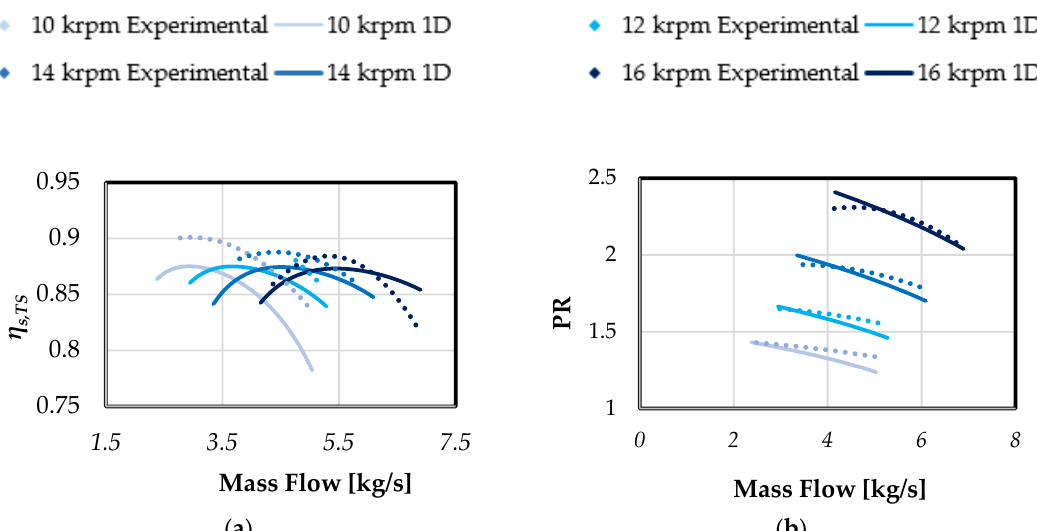
Figure 6. Compressor validation: characteristic maps for Eckardt impeller A. ( a ) Total to static isentropic